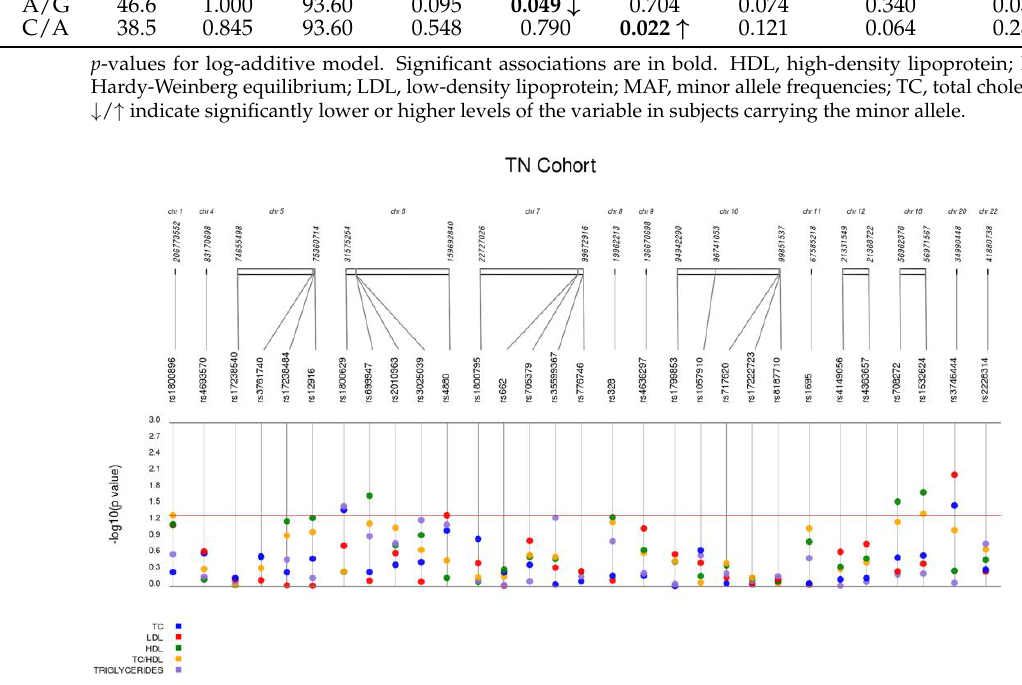
Figure 1. Results of the genetic associations with the baseline lipid traits in the treatment-naïve cohort. Table 3. Associations between polymorphisms and lipid profile in 125 subjects with moderate